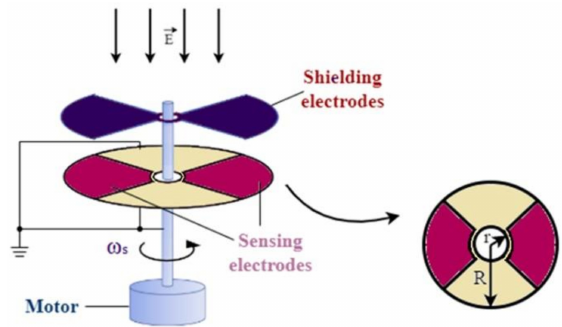
Figure 1. Shutter-type electric field mill